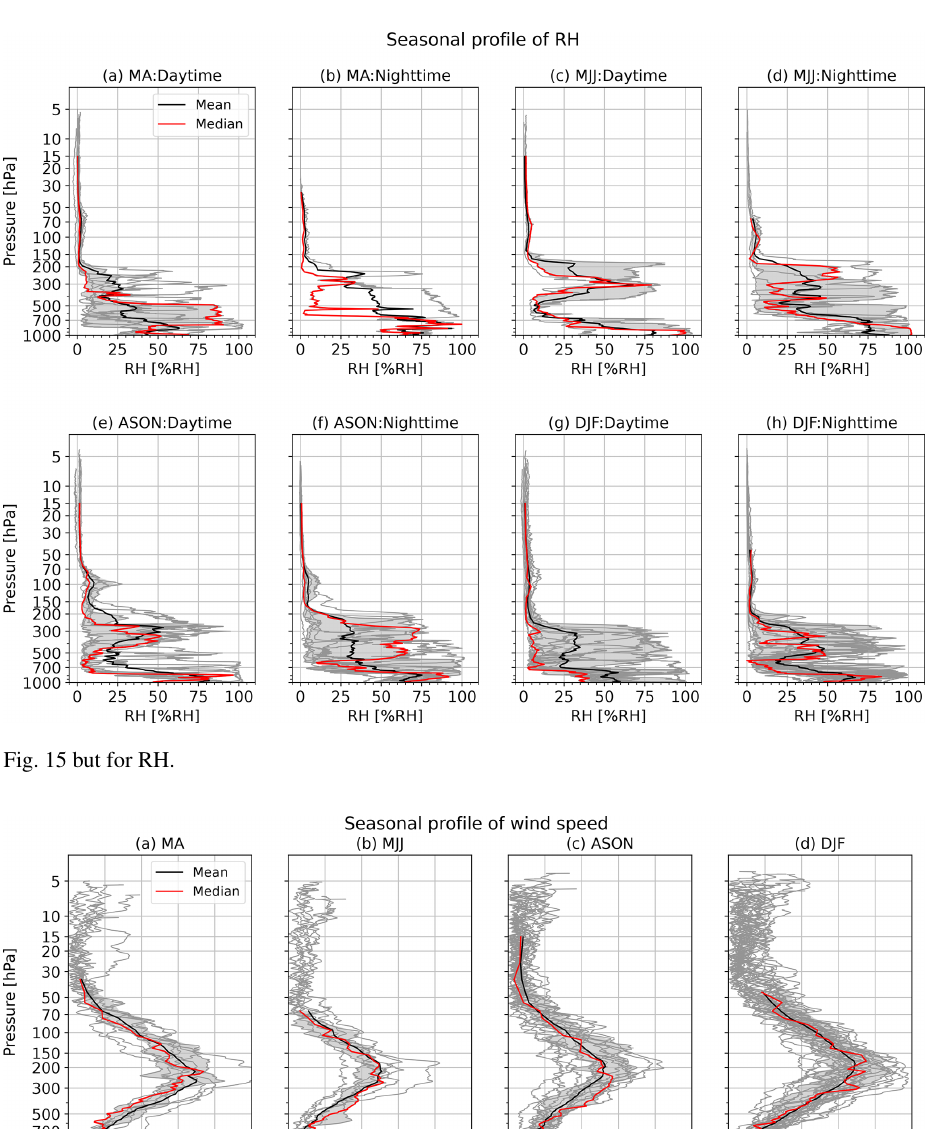
Figure 17. As per Fig. 15 but for wind speed.